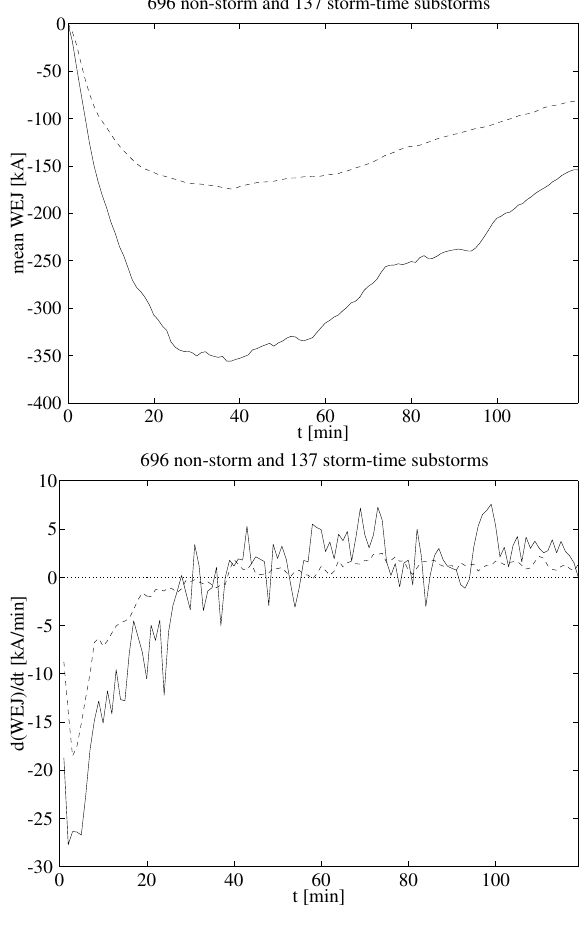
Fig. 10. Mean total westward electrojet (WEJ) and its time derivative during a non-storm (dashed line) and a storm-time substorm (uniform line). The origin of the time axis is the substorm onset, when the current is set to zero. than the time derivative. Consequently, relevant skin depths are larger for H than for d H /dt